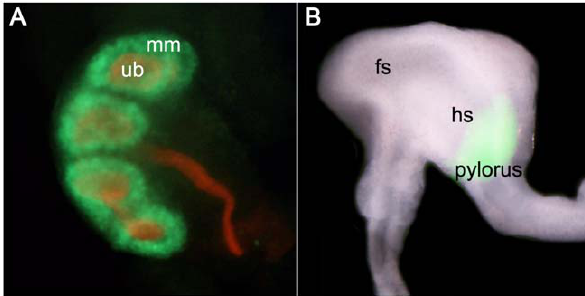
Figure 3. Whole mount expression pattern of Six2 -cre in E12.5 kidney and stomach. (A) Six2 -cre (GFP, green) is expressed in the cap metanephric mesenchyme (mm) surrounding the ureteric bud tips. Wnt9b expression and canonical Wnt signaling is highest in the ureteric bud which is labeled with cytokeratin (red). (B) In the stomach, Six2 -cre is expressed in the hindstomach and pyloric region. Canonical Wnt signaling activity is downregulated in this region [13].